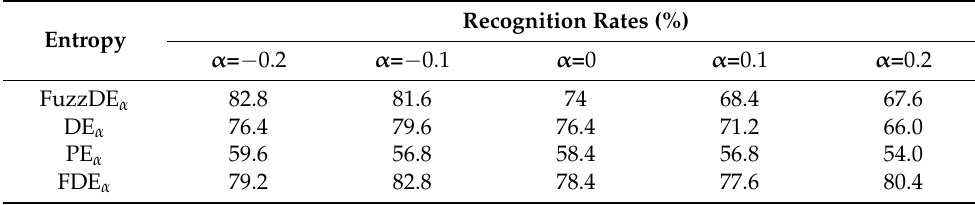
Table 2. Classification recognition rate of different entropies at various fractional